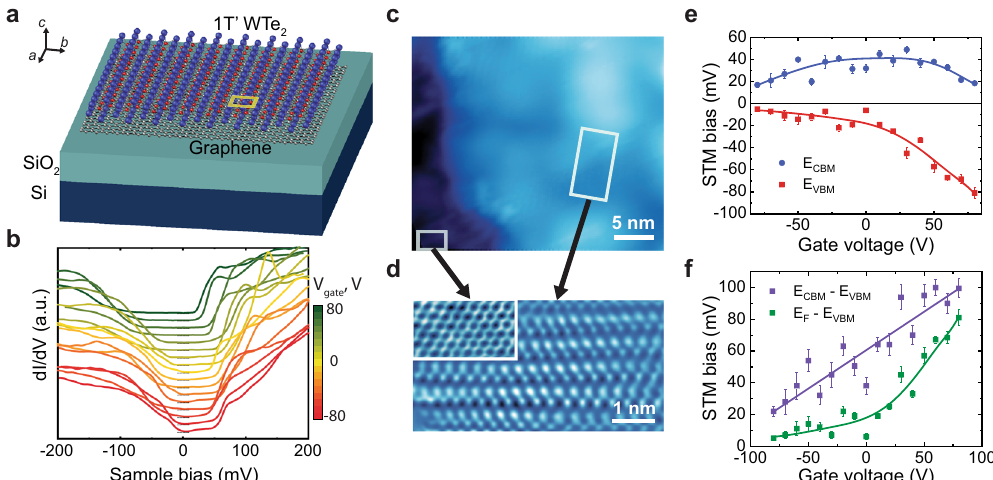
Fig. 4 Back-gated STM measurements of ML-WTe 2 on graphene on SiO 2 . a Schematic of the back-gating setup. b Evolution of the bulk d I / d V spectrum of a monolayer island in response to the gate voltage. c STM image of monolayer WTe 2 island on graphene on SiO 2 . d A zoom-in with atomic resolution showing Te atoms as well as the graphene lattice (inset). e Plots of the conduction band minimum and the valence band maximum for each spectrum at the given gate voltage (blue and red dots respectively) showing the non-trivial evolution of the bulk electronic structure with gate voltage. The blue and red lines are guides to the eye. The error bars are determined by the energy intervals at which data were obtained and the noise level of the d I/ d V spectra. f Same as ( e ) but with energies relative to the VBM. Back-gating changes the band gap (violet dots) as well as the position of the VBM with respect to E F (green dots). The violet and green lines are guides to the